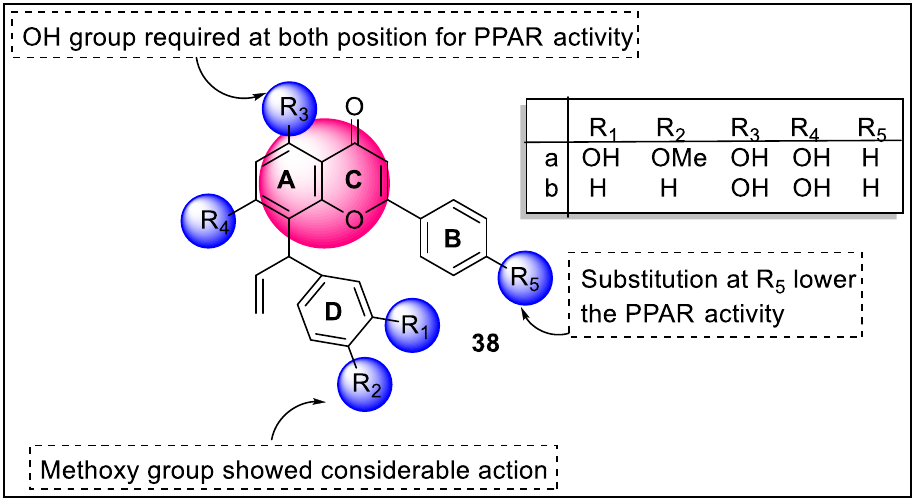
Figure 42. Structural activity relationship of chromenone hybrids ( 38 ) as potent PPAR